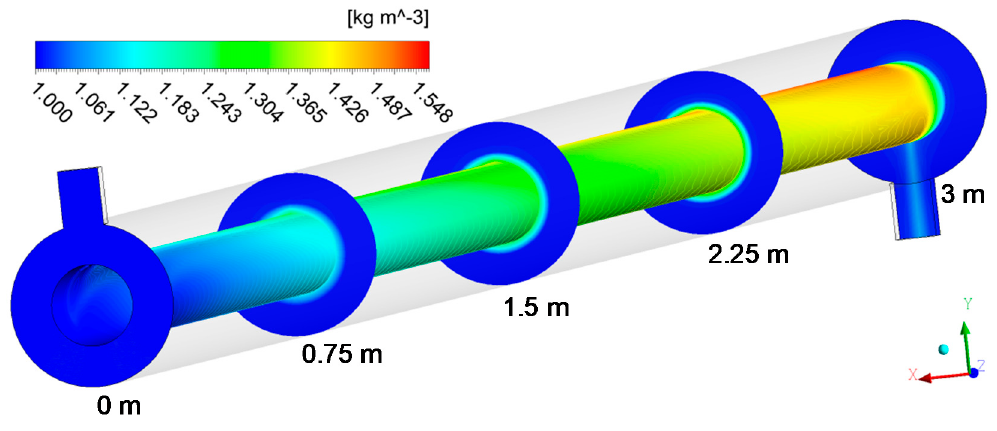
Figure 14. Oil concentration field inside the shell and tube module for T 0 = 55 °C (Case 6).